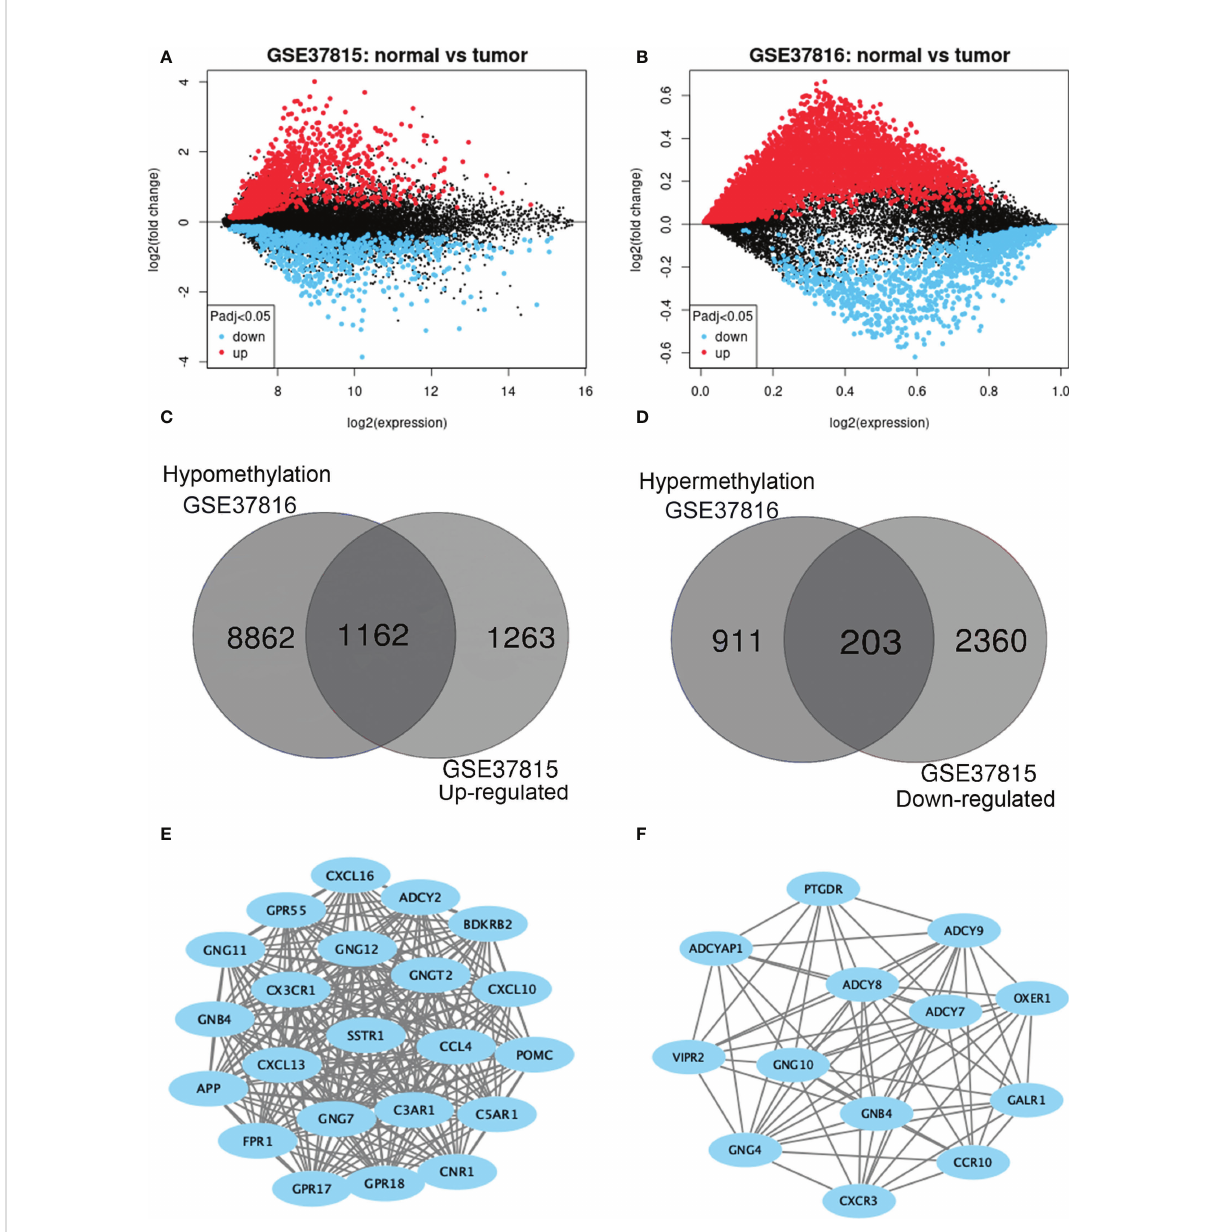
FIGURE 2 Identi fi cation of methylation-regulated differentially expressed genes (MeDEGs). (A, B) Mean difference plot of signi fi cantly differentially expressed genes (DEGs) in two independent validation sets. Red represents up-regulated genes, and blue represent down-regulated genes. (C, D) The up-regulated and down-regulated genes in the two validation sets were selected as intersections, respectively. (E, F) Constructed protein-protein interaction networks based on common